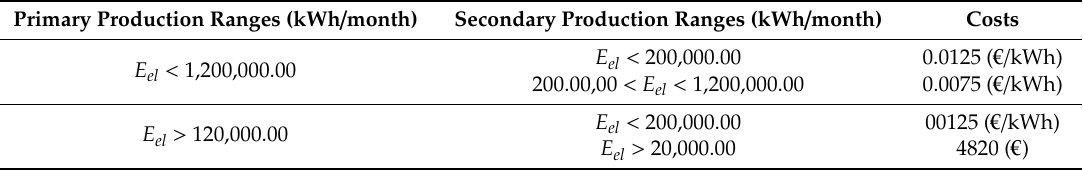
Table 4. Cost associated with the electricity production